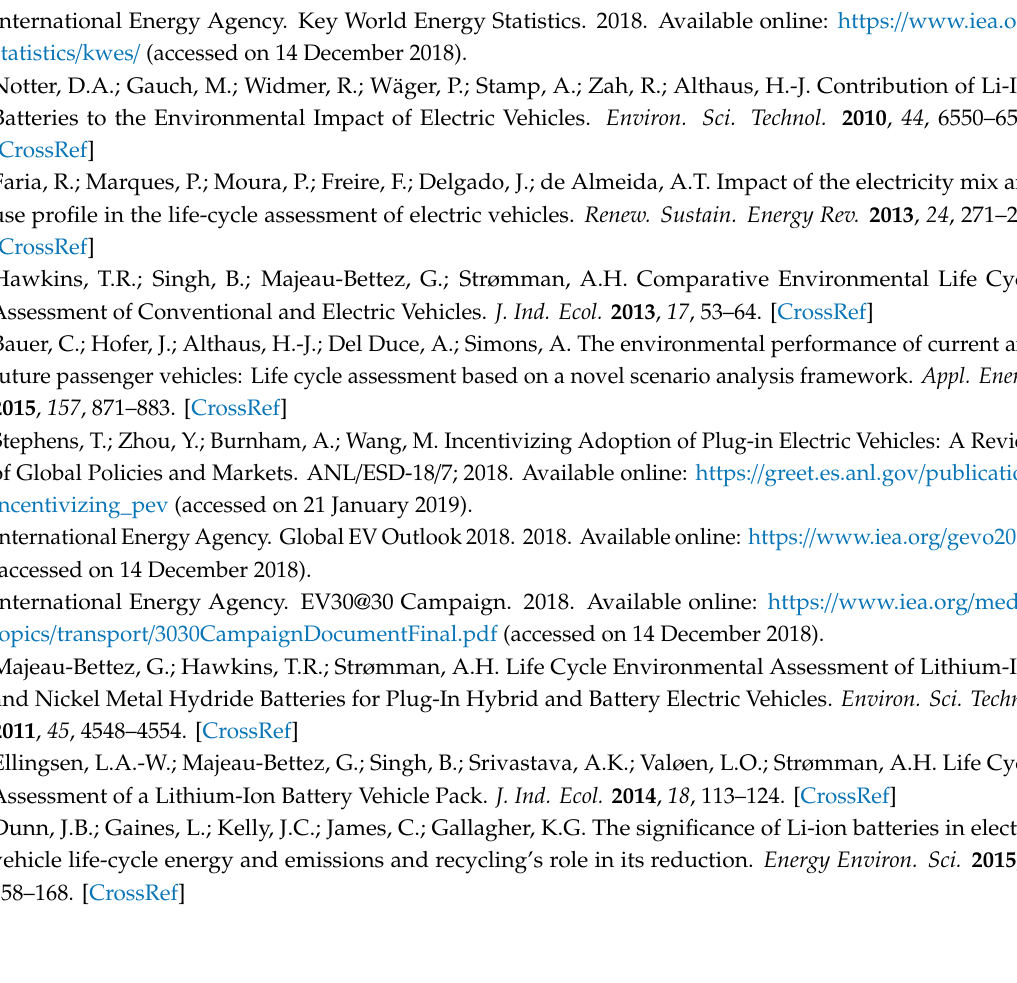
Figure S1: Geographical distribution of NMC111 battery production activities, Table S1: BOM of the reference 23.5 kWh NMC111 battery pack, Table S2: Cradle-to-gate LCA results for 1 kWh of NMC111 battery, Table S3: Impact intensities per-kg materials in the NMC battery, Table S4: Comparison of reported LCIs for NMC powder production, Table S5: Cradle-to-gate LCA results for 1 kg of NMC111